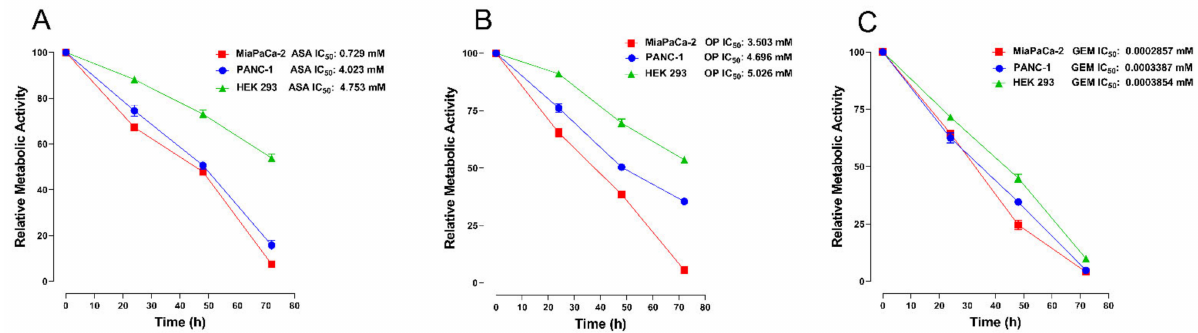
Figure 3. The effect of ASA, OP, and GEM treatment on the metabolic activity of pancreatic cancer cells at IC 50 values using the AlamarBlue live cell assay. MiaPaCa-2, PANC-1, and HEK 293 cells, as immortalized non-malignant control cells, were plated in 96-well plates at 20,000 cells/well density and treated with indicated IC 50 concentrations of ( A ) ASA, ( B ) OP, and ( C ) GEM for 72 h to identify metabolically active cells following drug treatment. Data are presented as mean ± SEM of 3 independent experiments performed in triplicates. Abbreviations: IC 50 , half-maximal inhibitory concentration; ASA, aspirin; OP, oseltamivir phosphate; GEM, gemcitabine; SEM, standard error of the